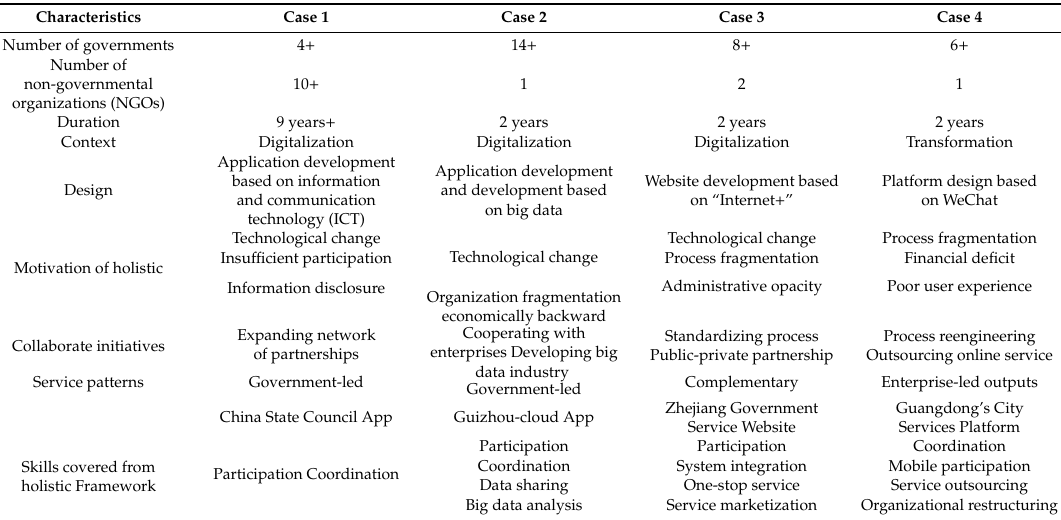
Table 3. Overview of the characteristics of the four